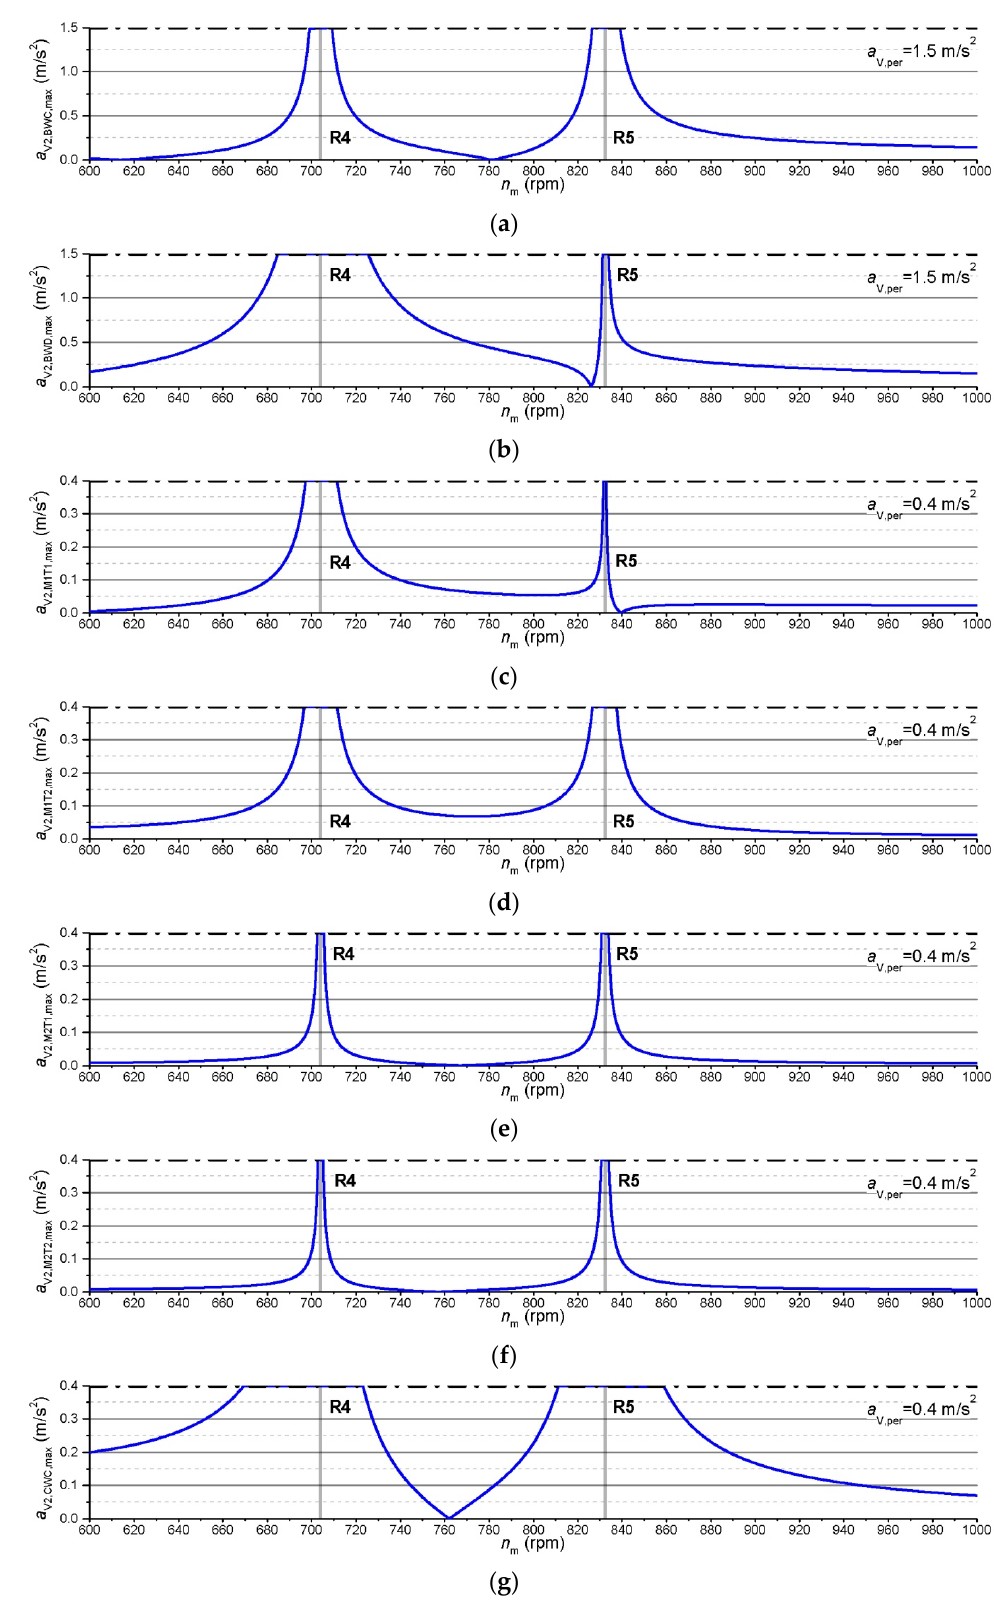
Figure 6. Response to the second harmonic of excitation—maximal vertical accelerations of the referent points of the slewing superstructure: ( a ) BWC; ( b ) BWD; ( c ) M1T1; ( d ) M1T2; ( e ) M2T1; ( f ) M2T2; ( g ) CWC.